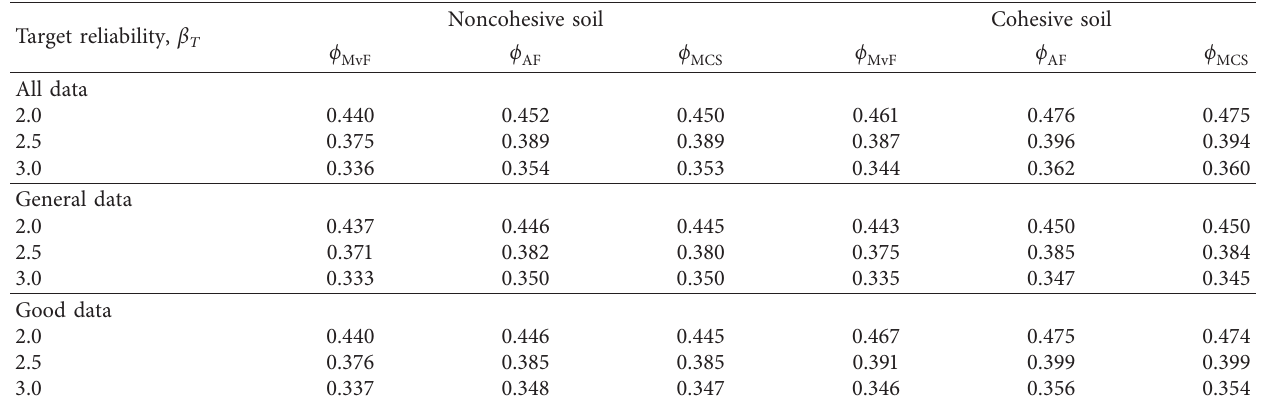
Table 6: Calculation results of resistance